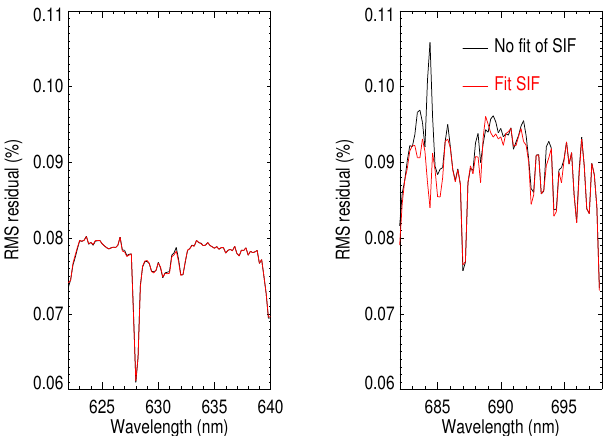
Figure 4. Root mean square (RMS) of simulated radiance residu- als (observed minus computed, in % of radiance) at wavelengths in and around the O 2 γ band (left) and B band (right) from the test- ing data set with FWHM = 0.5nm and nominal noise model when fluorescence (SIF) is fit/retrieved (red) and when it is not